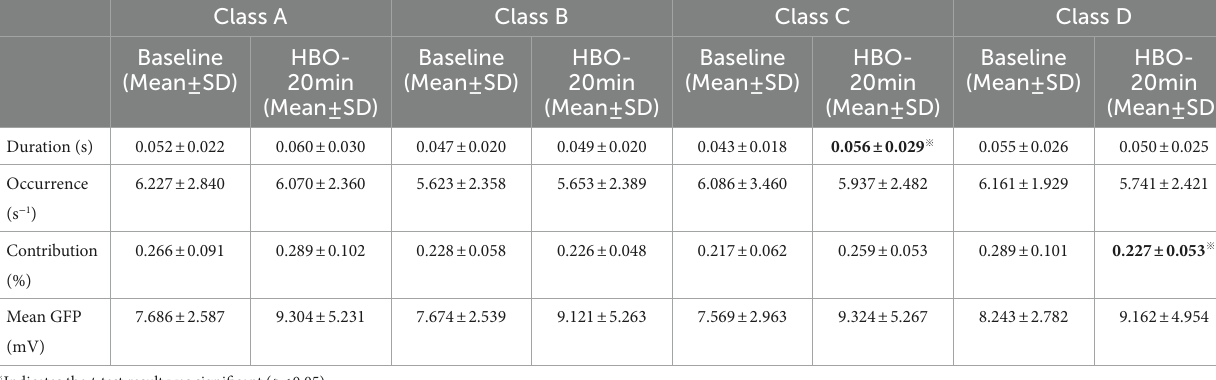
TABLE 4 EEG microstate duration, occurrence, contribution and mean GFP analysis results of DOC patients (17 cases) with CRS-R ≥